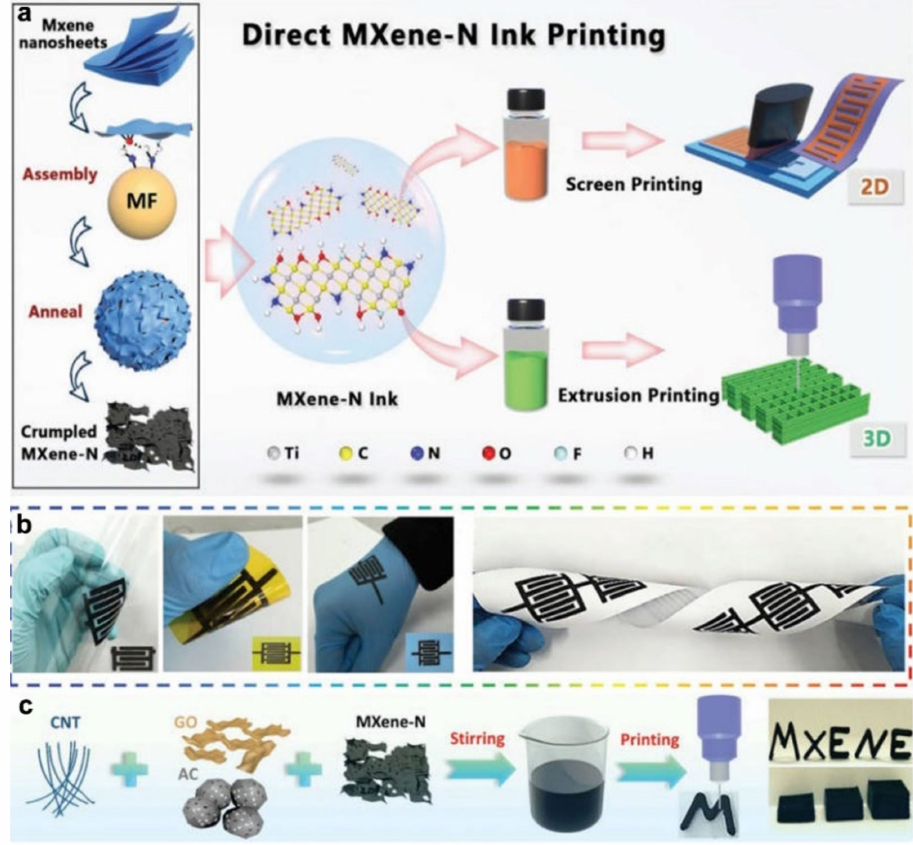
Figure 9. ( a ) Schematic illustration of the synthetic procedure for the crumpled MXene-N and the direct MXene-N ink printing routes of screen printing and extrusion printing. ( b ) Digital photographs of the MSC printed by screen printing. ( c ) Schematic showing of the preparation process of MXene-N based hybrid ink and the extrusion printed 3D architecture